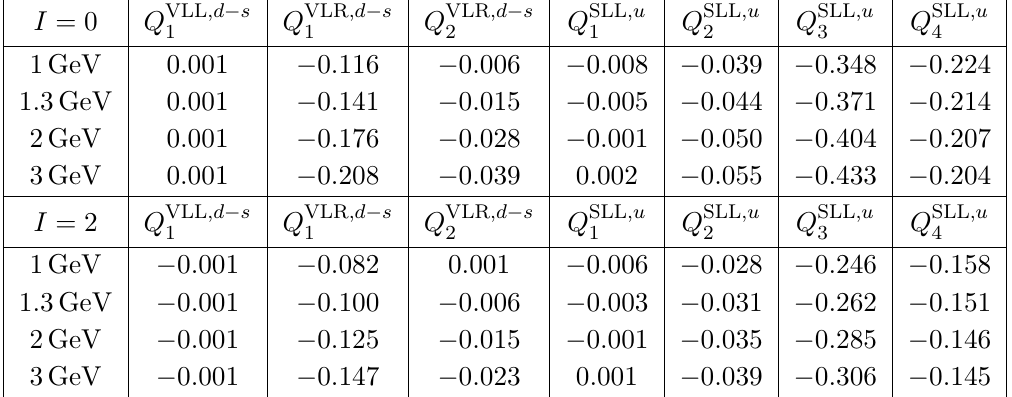
Table 4 . Matrix elements h X i i 0 ; 2 of BSM operators in the SD basis allowed by SMEFT contributing to the isospin amplitudes A 0 ; 2 in units of GeV 3 for four values of (cid:22) .